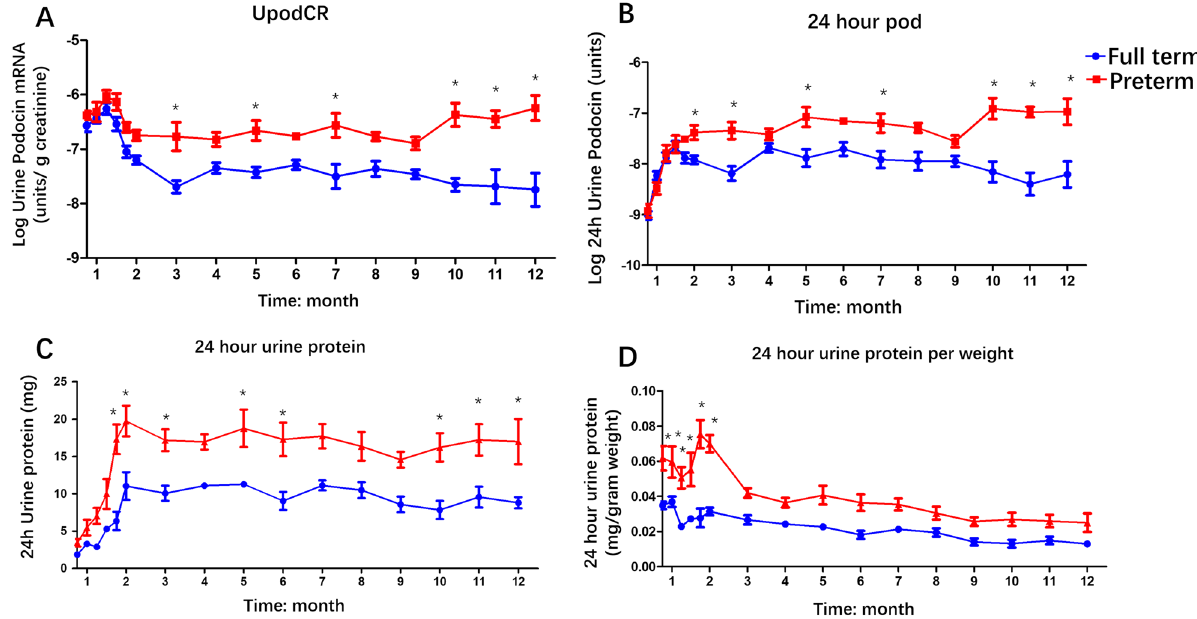
Figure 3. Time course of urine podocin mRNA depletion and urine protein in full-term rats and preterm rats ( A , B ). The rate of urine podocyte mRNAs depletion is expressed as the urine podocin mRNA-to-creatinine ratio (UpodCR) ( A ) and the 24-h excretion of podocin mRNA (24 h Upod) ( B ). At 3, 5, 7, 10, 11, 12 months of age in UpodCR and at 2, 2, 5, 7, 10, 11, 12 months of age in 24 h Upod, urine podocyte depletion was significantly increased in the preterm rats compared with the full-term rats at each time points. Statistically significant differences are shown by asterisks. ( C , D ) Proteinuria was expressed as 24-h urine protein (24 h UP) (C) and 24-h UP corrected by weight (D). Twenty-four-hour proteinuria was increased in the preterm rats over an all-time course from 3 weeks of age to 12 months of age compared with that in the full-term rats. At the ages of 1.75, 2, 3, 5, 6, 10, 11, and 12 month in 24 h UP and at the age of within 2 months in 24-h UP per weight, urine protein was significantly increased in preterm rats compared with full-term rats. (Two-way ANOVA was employed to examine changes over multiple time points and Bonferroni post-hoc tests were used to compare groups at individual time points. * P <